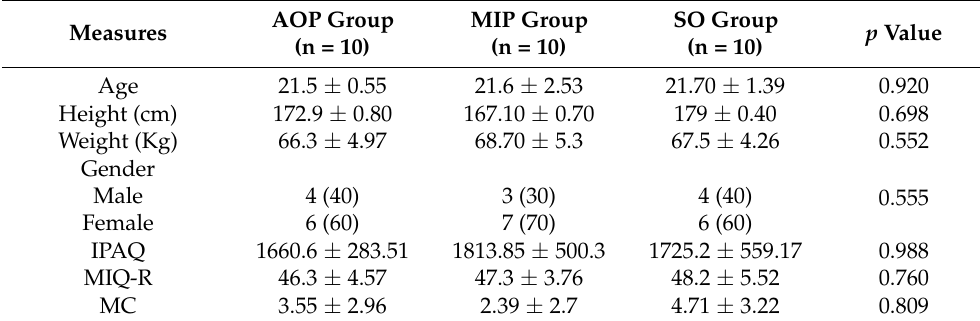
Table 1. Descriptive statistics of sociodemographic and baseline